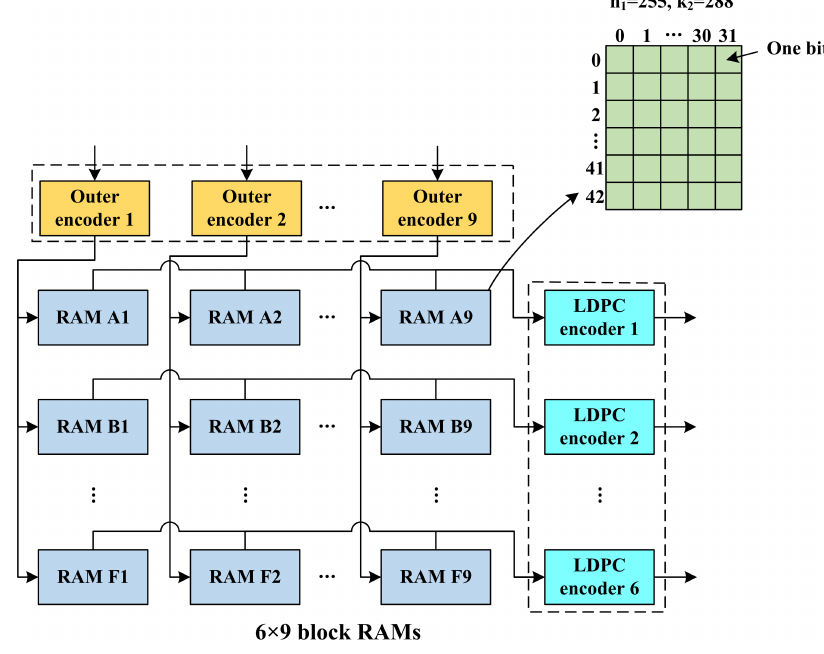
Figure 10. The encoder architecture of product